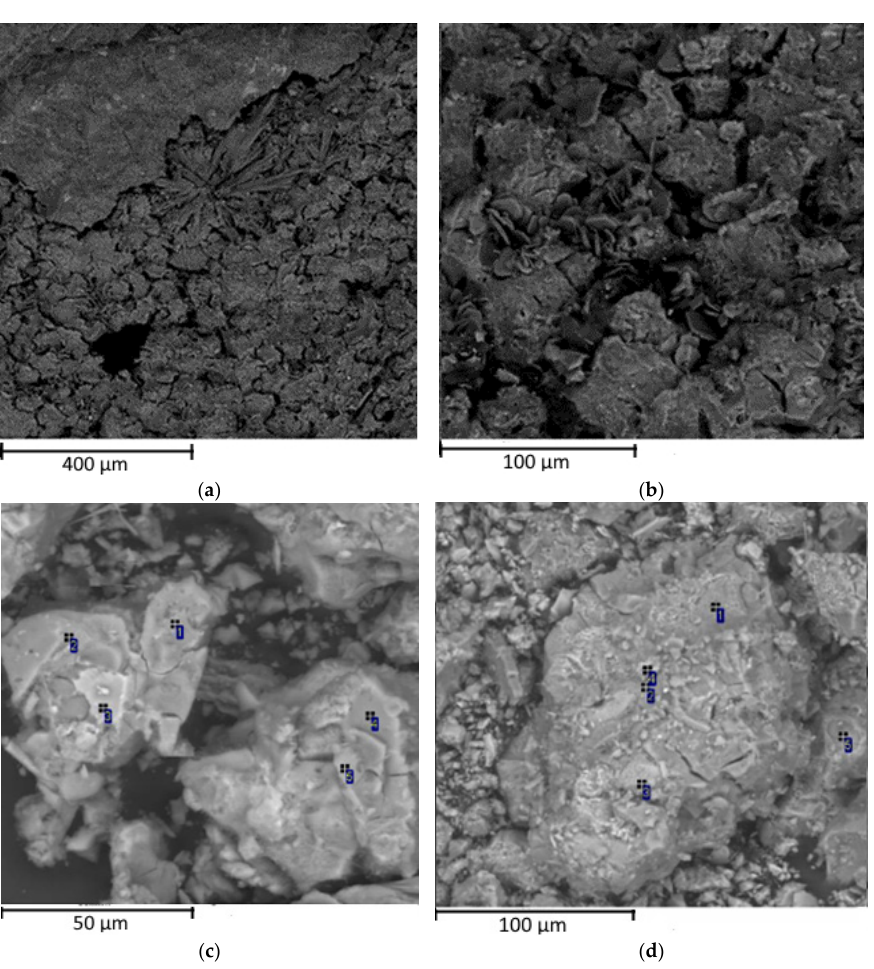
Figure 6. Microstructures of the AAMs with aspiration dust: ( a ) needle crystals, ( b ) lamellar crystals, ( c , d ) clusters.